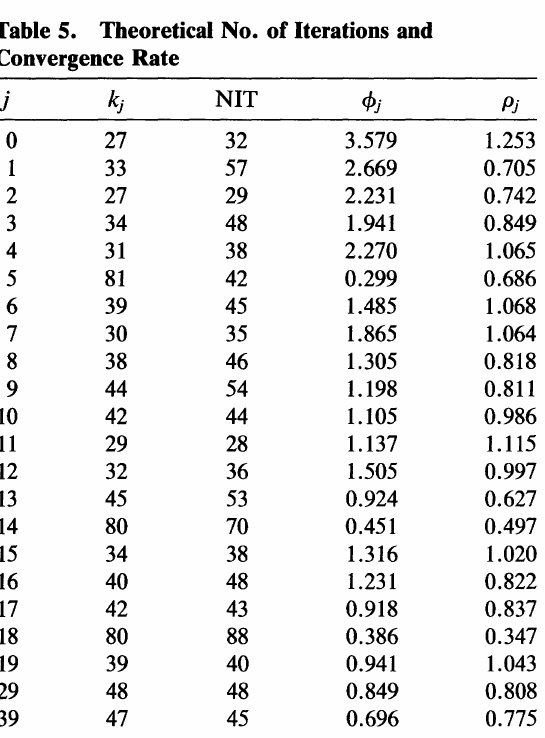
Table 5. Theoretical No. of Iterations and